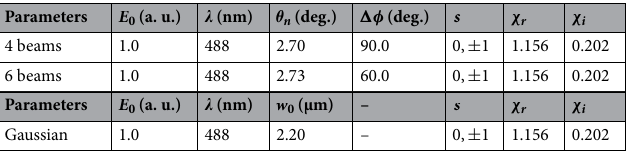
Table 1. Parameters used in the simulations of the optical radiation force and light intensity distribution shown in Fig. 2.